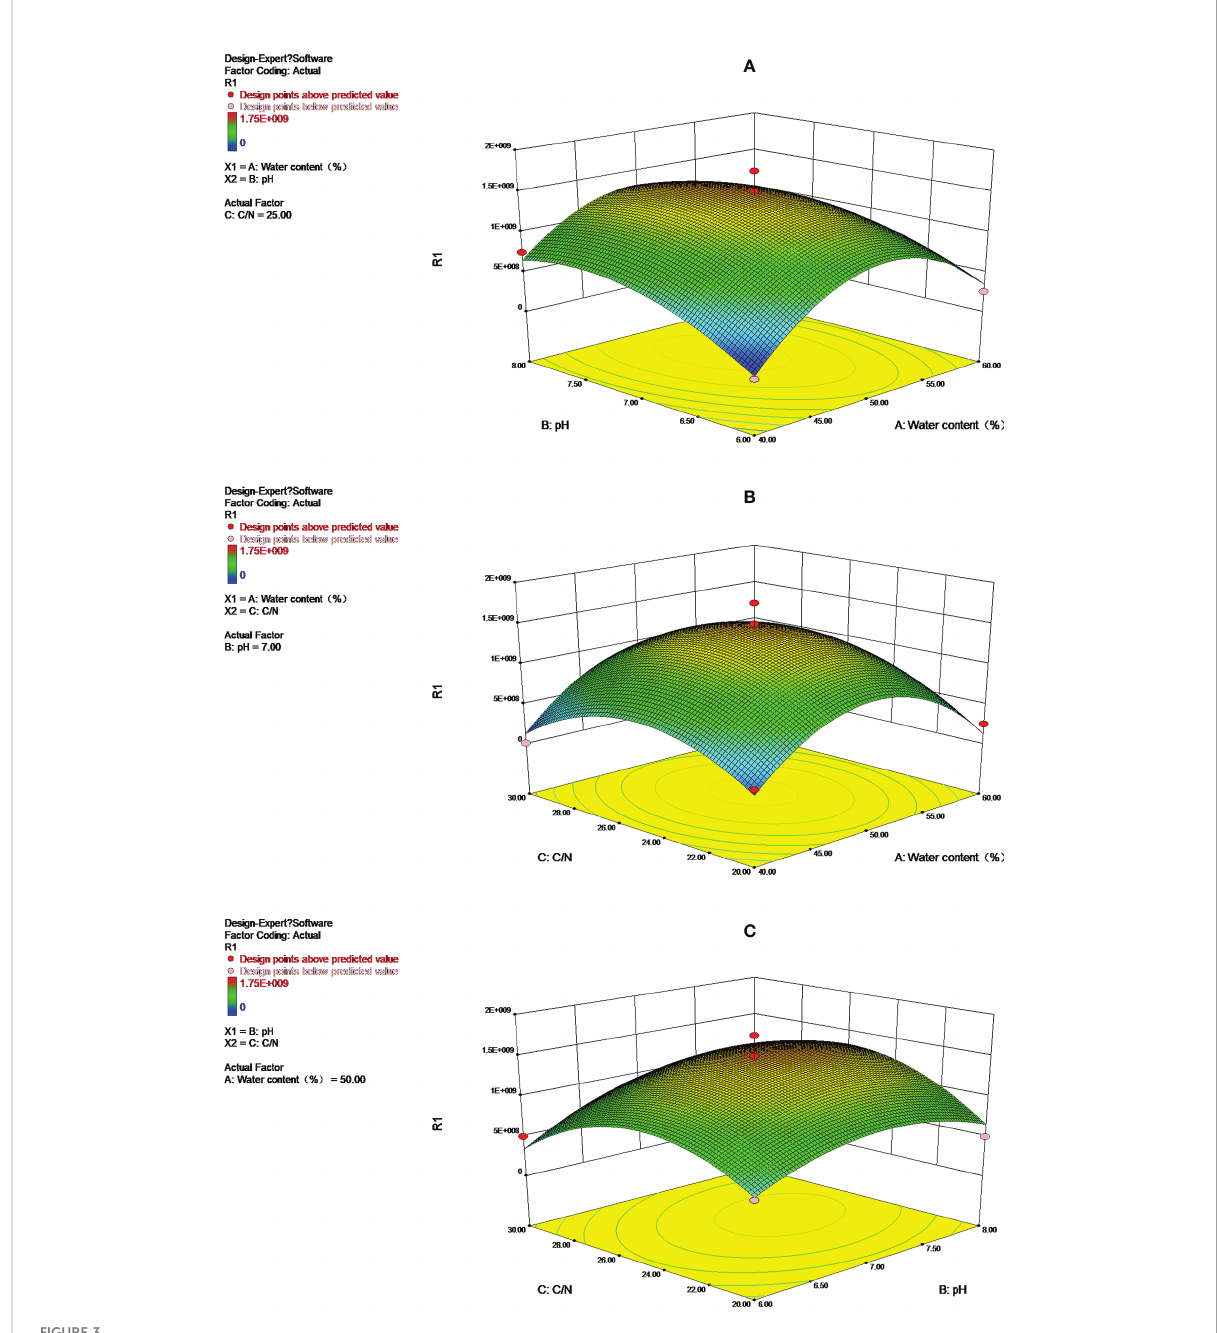
FIGURE 3 Response surface and contours to: (A) Y=f (A, B) ; (B) Y=f (A, C) ; (C) Y=f (B, C)